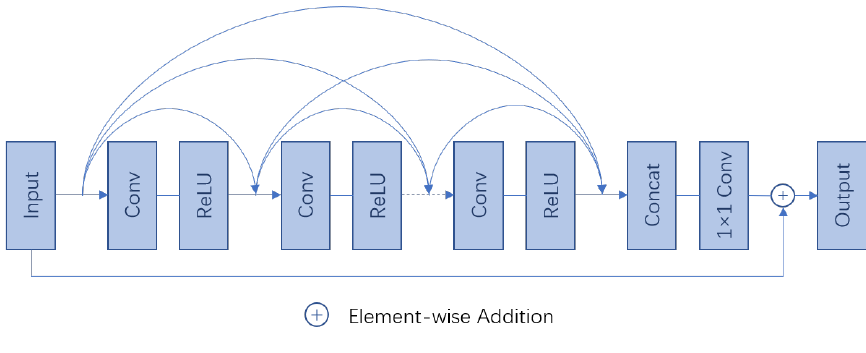
Figure 3. The RDCB schematic.